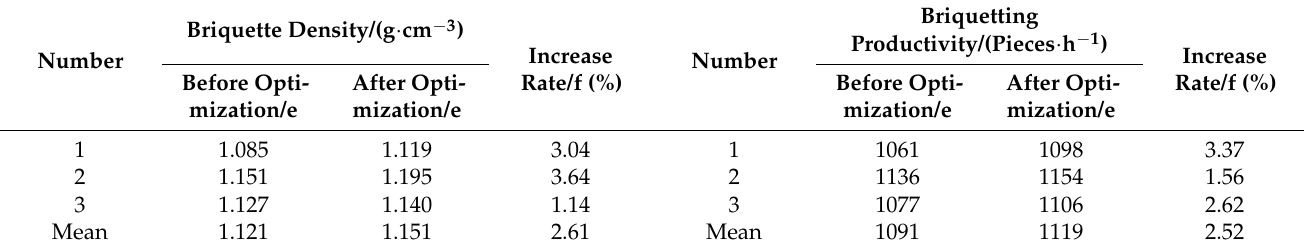
Table 3. Verification of test